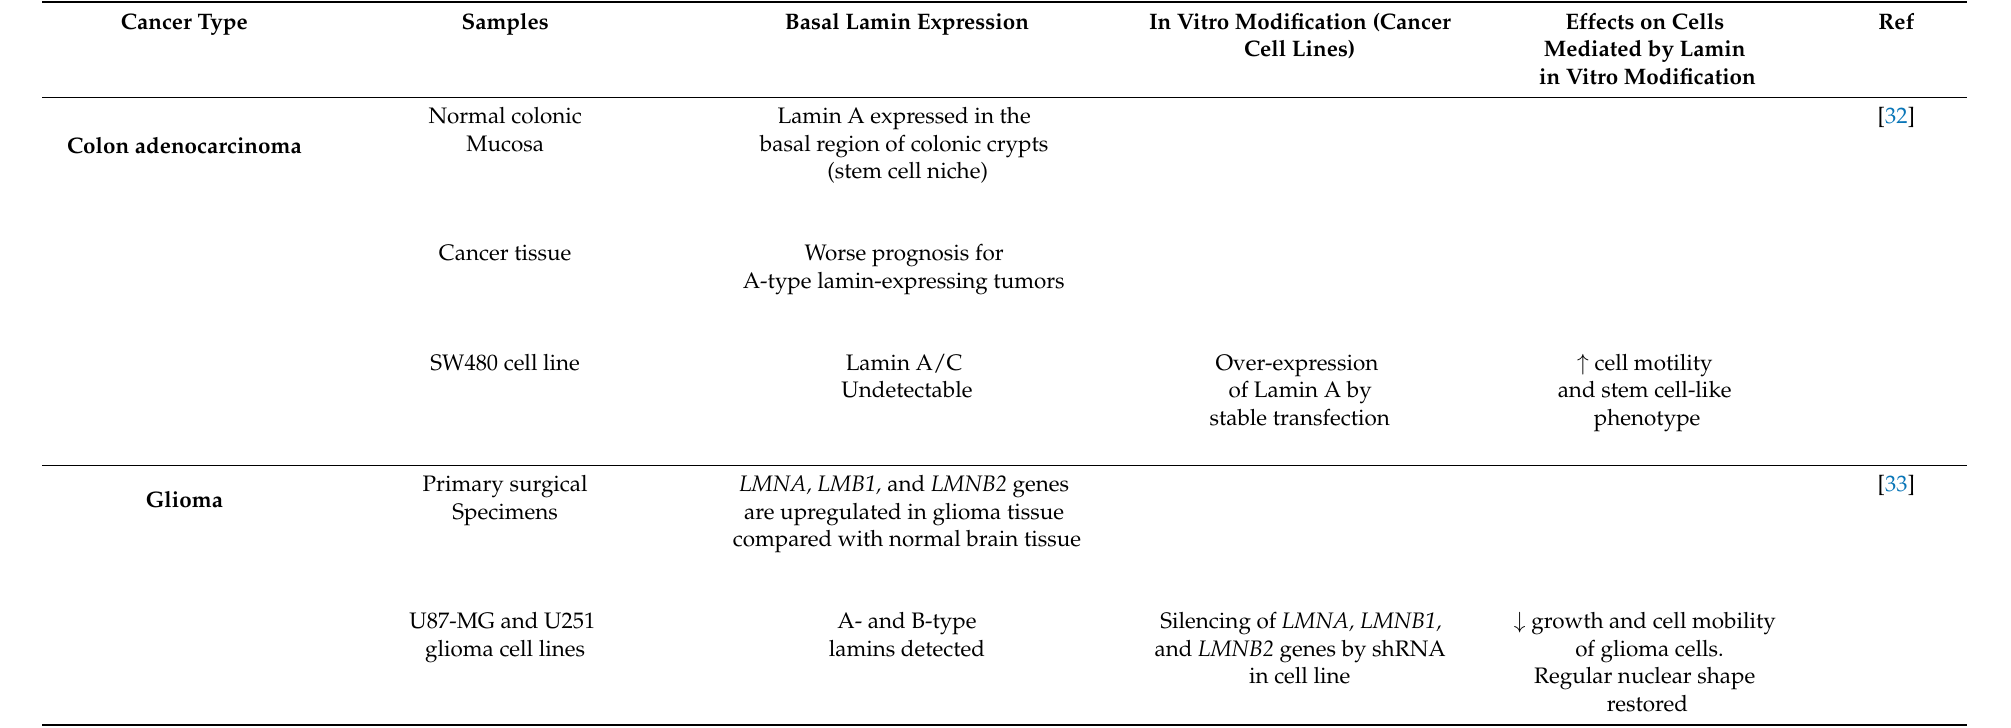
Table 1. Lamin expression in primary cancer tissues and in cancer cell lines. Referring to the text, for each cancer type we have specified the samples assessed in the relative work, the basal lamin expression, and how in vitro modification of lamin expression impacts the tumoral behavior of cancer cell lines. ↑ = increase. ↓ =